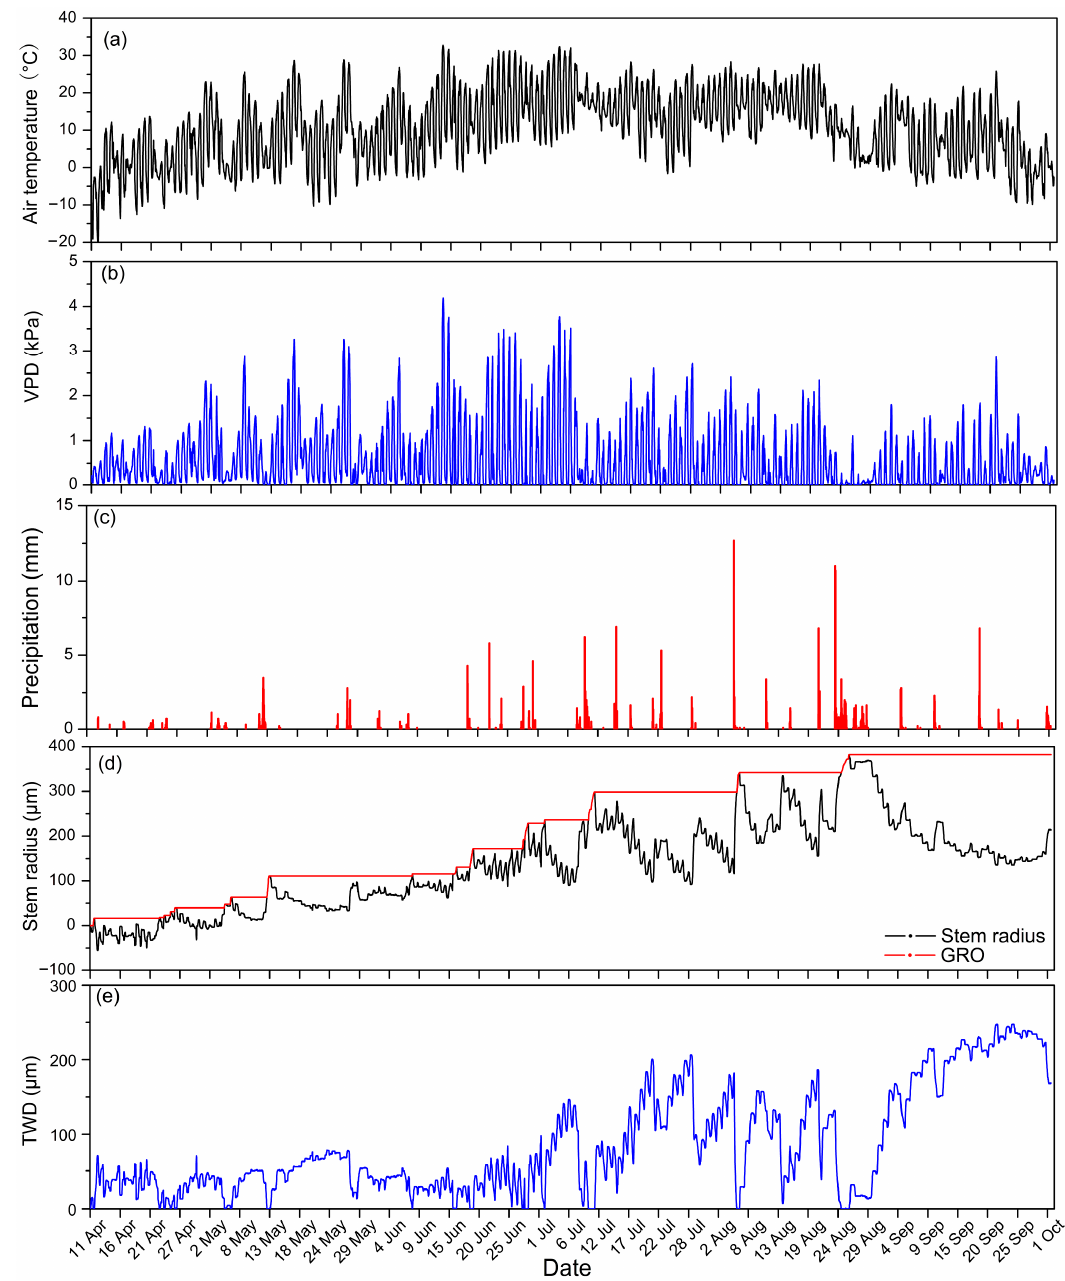
Figure 2. ( a ) Seasonal course of mean halfhour air temperature, ( b ) halfhour mean of vapour pressure deficit (VPD) and ( c ) daily totals of precipitation. ( d ) Seasonal changes of halfhour mean of stem radius partitioned into tree water deficit-induced stem shrinkage (TWD), and ( e ) growth-induced irreversible stem expansion (GRO) in 2017.